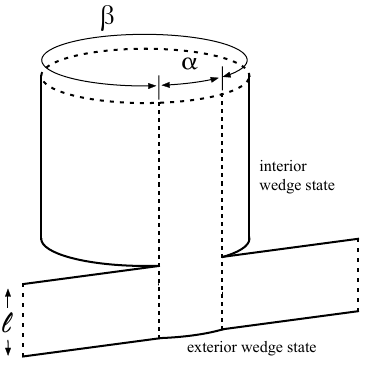
Figure 10 . The (cid:13)ag-anti-(cid:13)ag